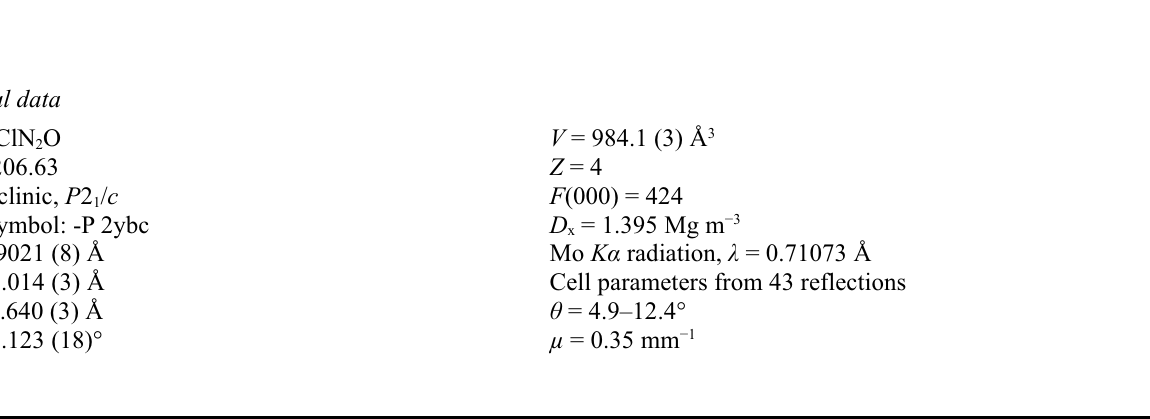
The molecular packing of (I) viewed along the a axis. H atoms and atoms of the minor disorder component have been